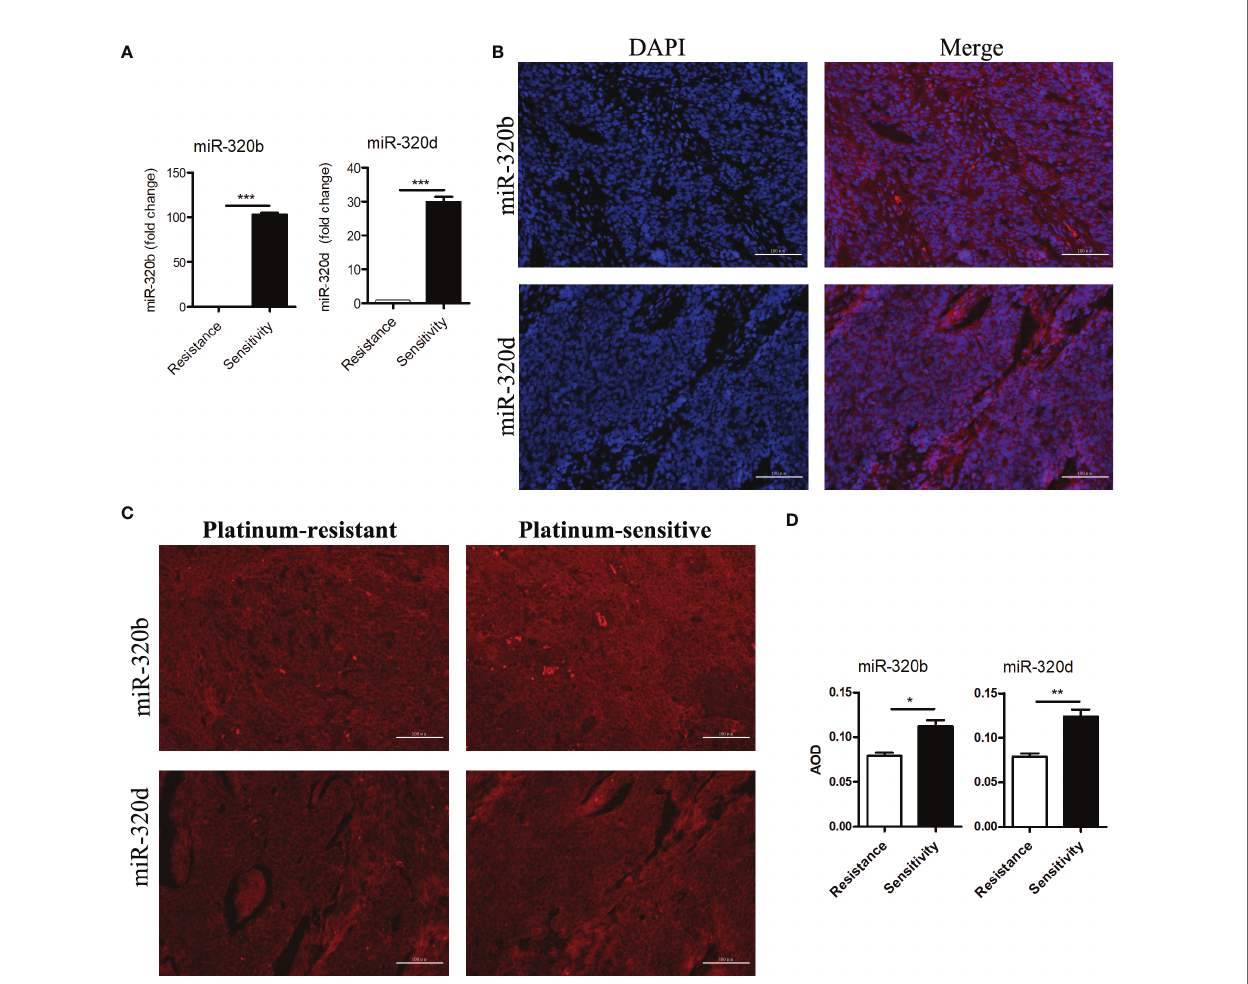
FIGURE 5 | Differential expressions of miR-320b and miR-320d between platinum-resistant and platinum-sensitive ovarian cancer tissues were veri fi ed by RT-PCR and FISH. (A) Expression levels of miR-320b and miR-320d in ovarian cancer tissues by RT-PCR. (B) Cellular localization of miR-320b and miR-320d in ovarian cancer tissues by FISH. (C, D) Quantitative analysis of miR-320b and miR-320d in ovarian cancer tissues by FISH. ***p<0.001. RT-PCR, real-time polymerase chain reaction; FISH, fl uorescence in situ hybridization experiment. *p < 0.05; **P <